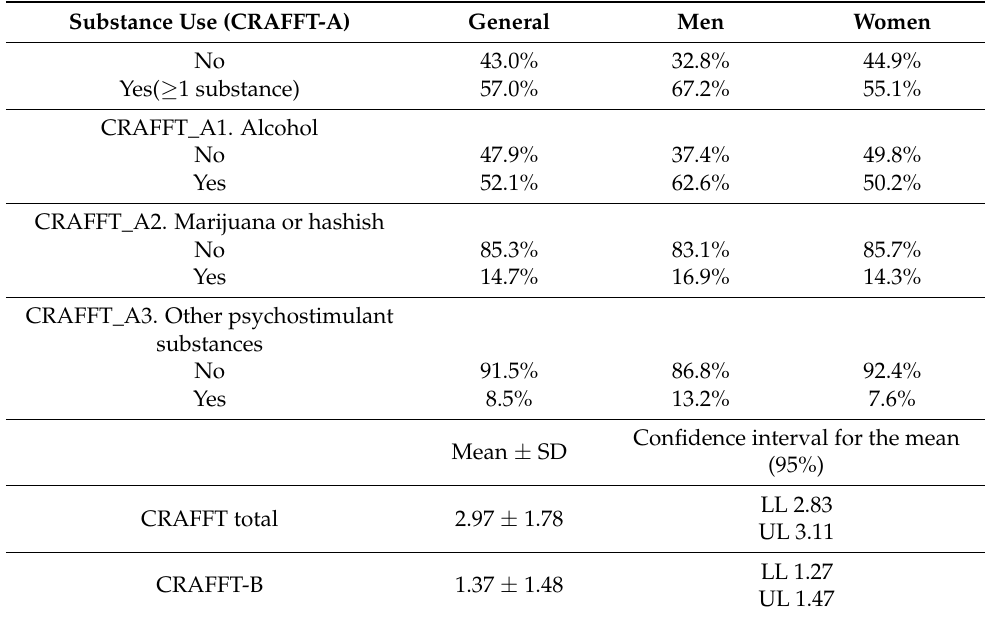
Table 2. Descriptive for CRAFFT total score and Substance use (CRAFFT-A) and consequences of its consumption using CRAFFT-B